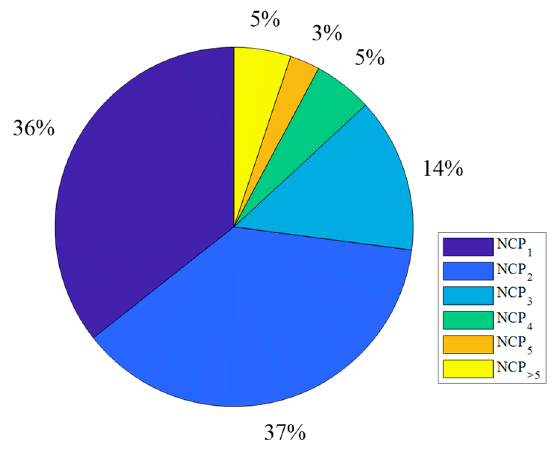
Figure 10. Normalized number of points where calculations were made exactly r times for TX-RX distance equals to 1 km.